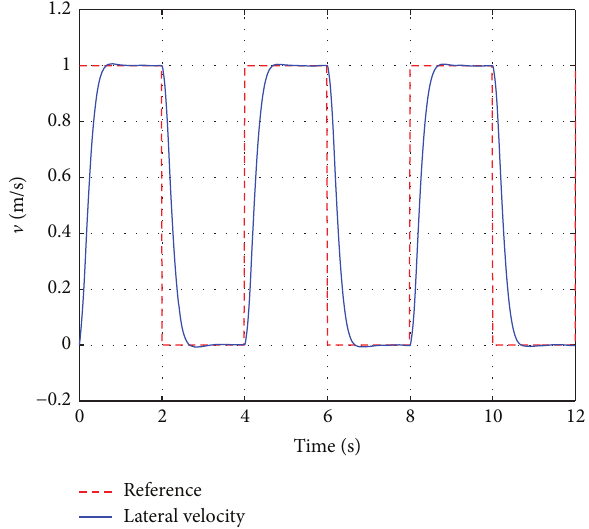
Figure 5: The performance of speed tracking in lateral channel.